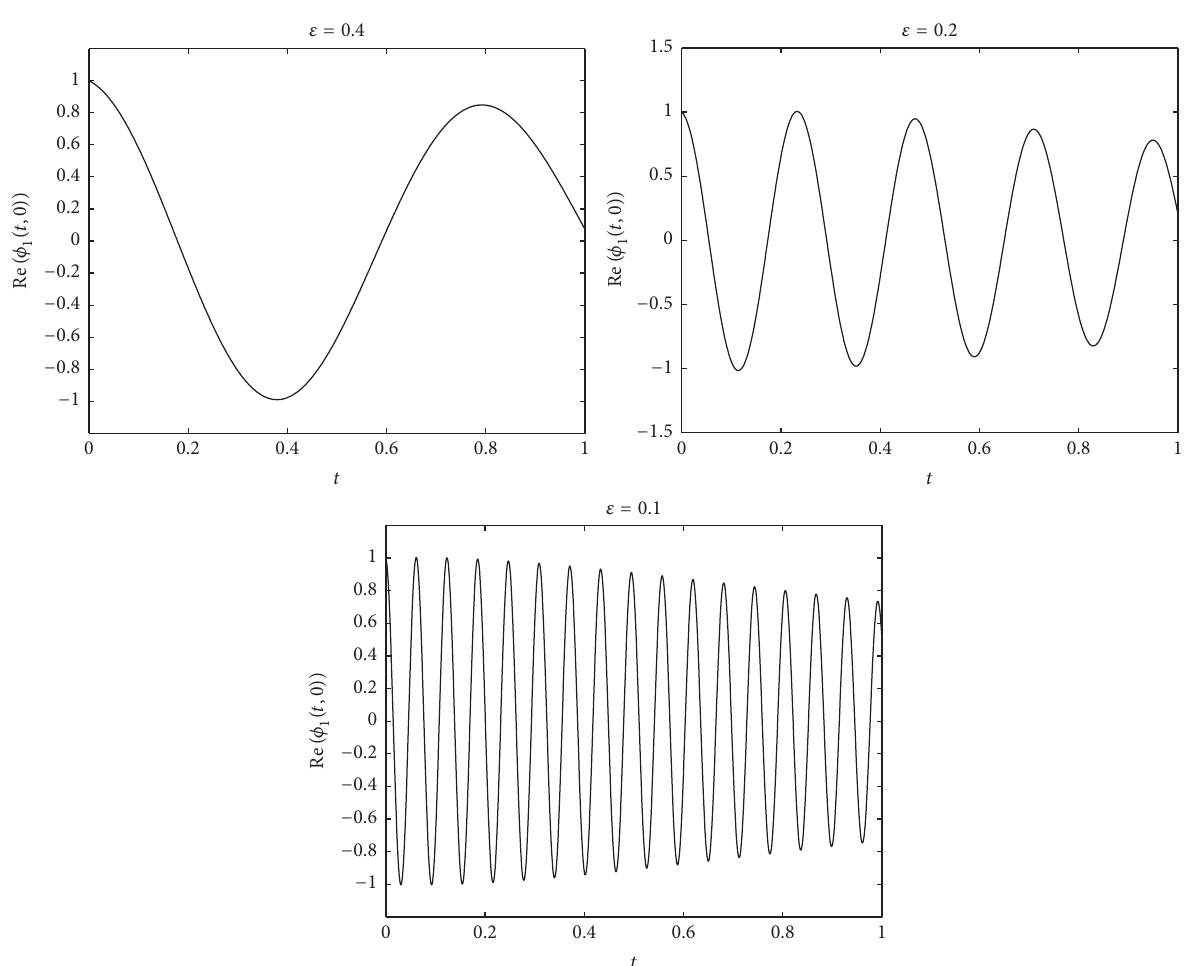
Figure 2: Oscillation of Dirac equation (1) with different 𝜀 = 0.4 , 0.2 , and 0.1